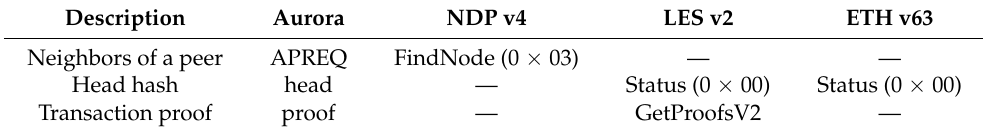
Table 1. Mapping of Aurora requirements to Ethereum P2P protocol